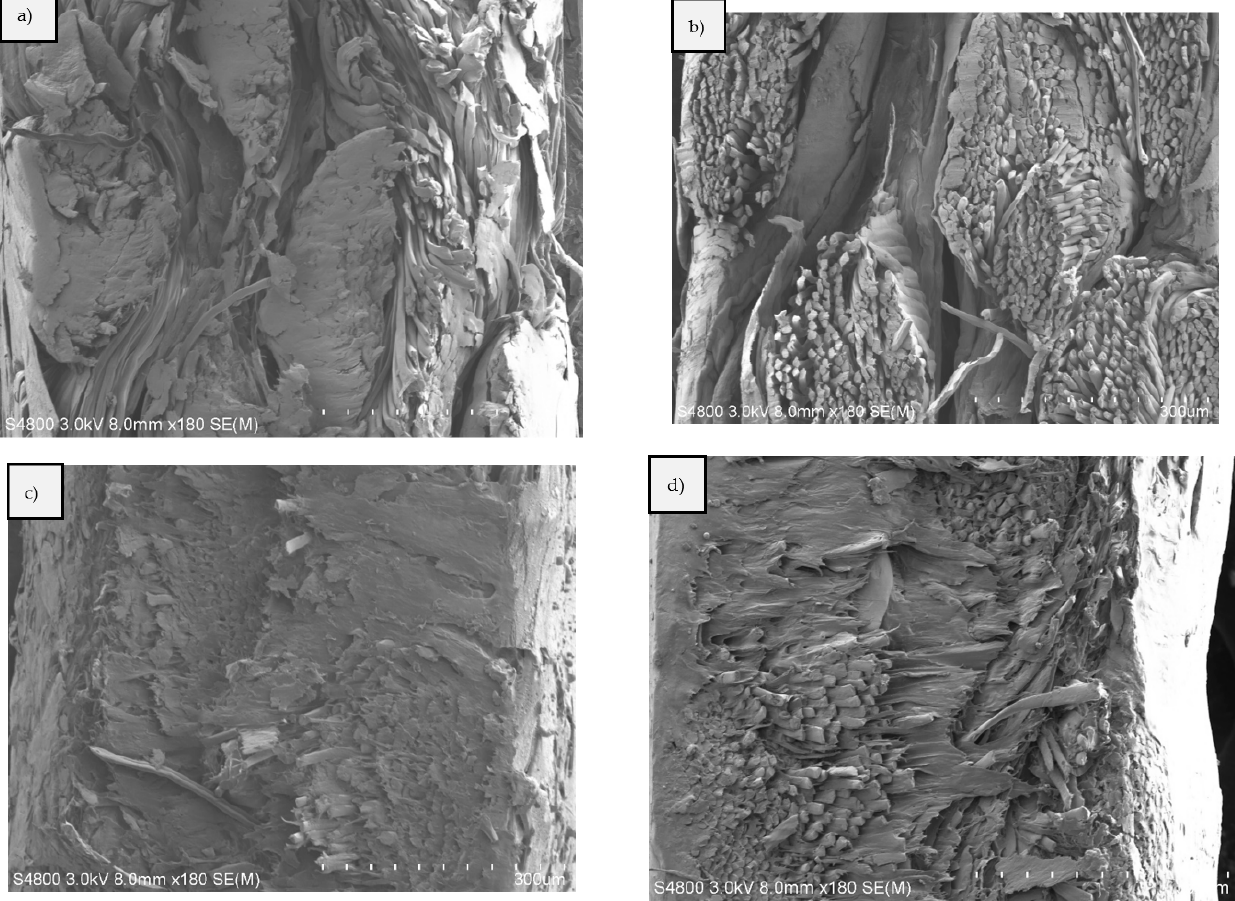
Figure 12. SEM pictures of the composites: ( a ) S-ACC, ( b ) L-ACC, ( c ) S-BC2 and ( d ) L-BC2, with a magnification of 180×.